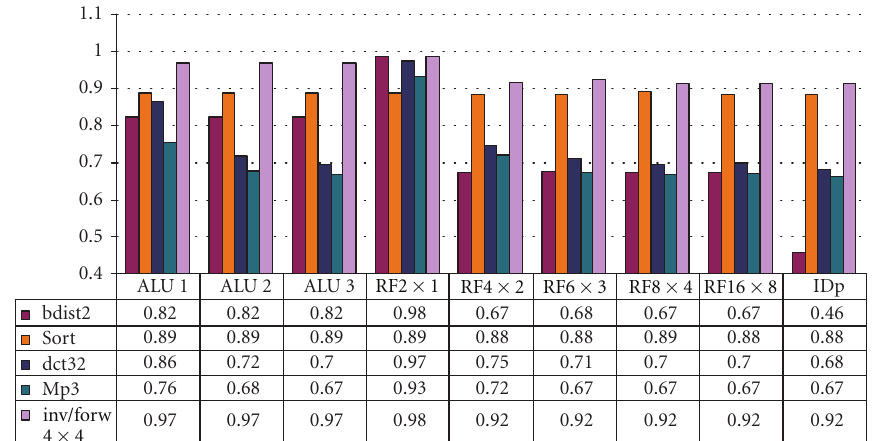
Figure 8: Relative number of execution cycles on nonpipelined data paths generated for di ff erent resource constraints.